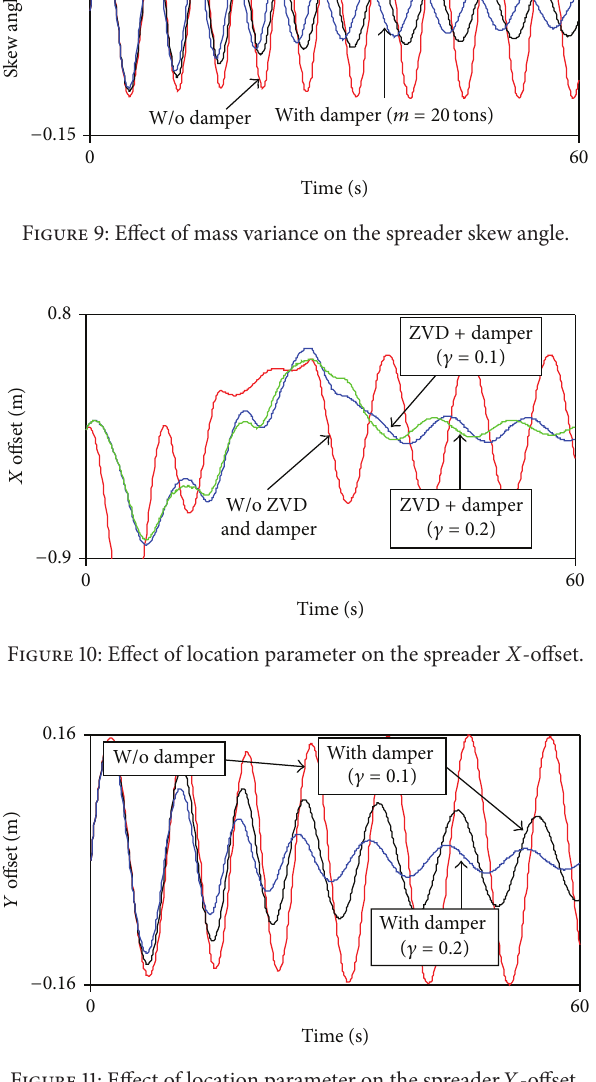
Figure 11: Effect of location parameter on the spreader 𝑌